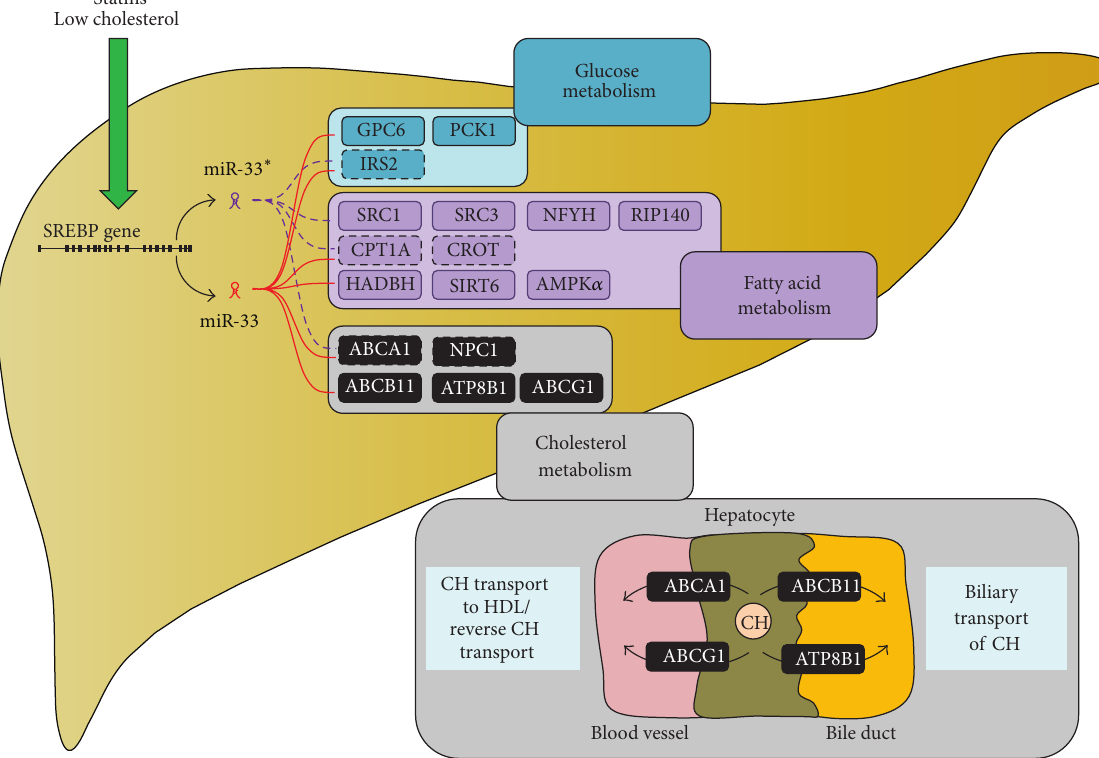
Figure 1: MicroRNA-33/33 ∗ effects. MicroRNA-33/33 ∗ are transcribed from the intron of the SREBP gene. Statins and low circulating cholesterol levels promote this process. Both miRNAs also target a variety of mRNAs involved in the glucose, fatty acid, and cholesterol metabolism. In the cholesterol metabolism, their targets include molecules involved both in cholesterol transport to HDL/reverse cholesterol transport and the transport of cholesterol to bile. CH: cholesterol; all other abbreviations are explained in the